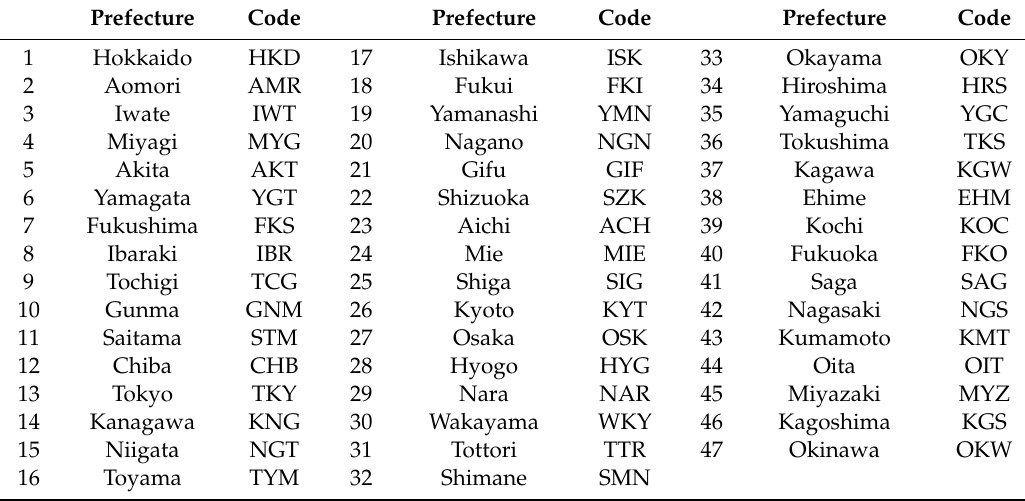
Table 4. 47 prefectures in